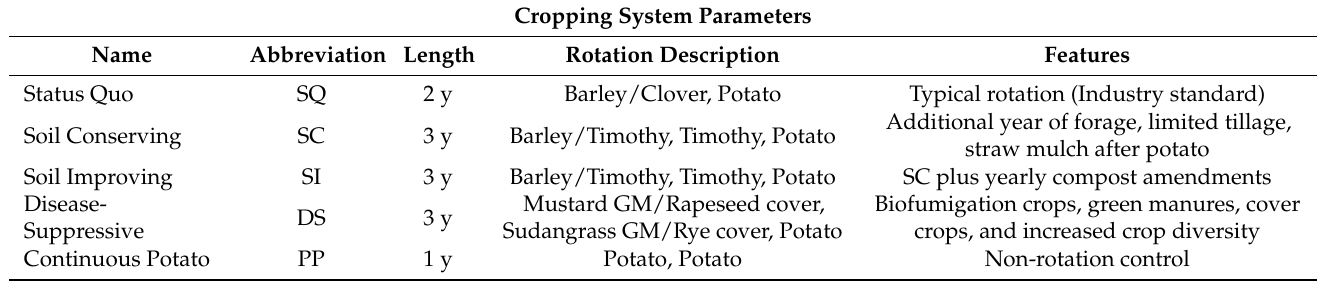
Table 1. Names, descriptions, and features of the cropping systems used to address specific management goals in these